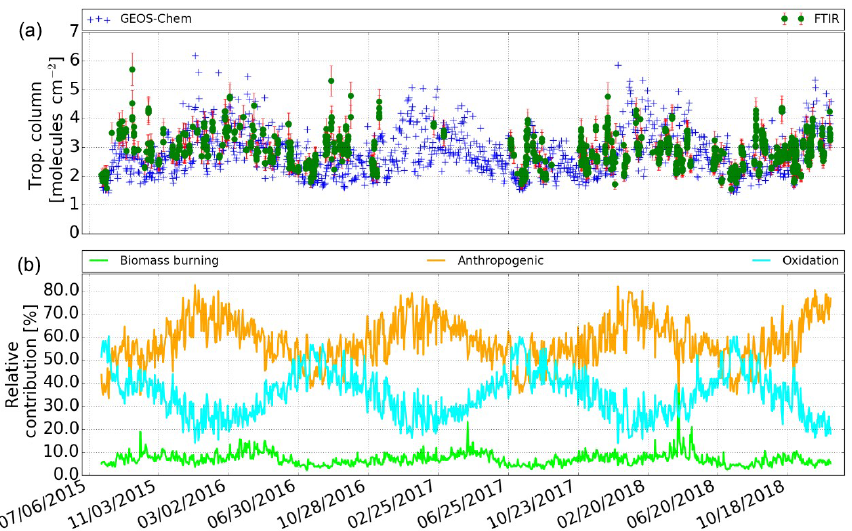
Figure 8. Daily mean CO tropospheric column time series of FTIR and GEOS-Chem (a) from 2015 to 2018 at Hefei (32 ◦ N). Panel (b) shows the relative contribution (%) of the anthropogenic, biomass burning, and oxidation tracers in the GEOS-Chem simulation to the total CO tropospheric columns at Hefei (32 ◦